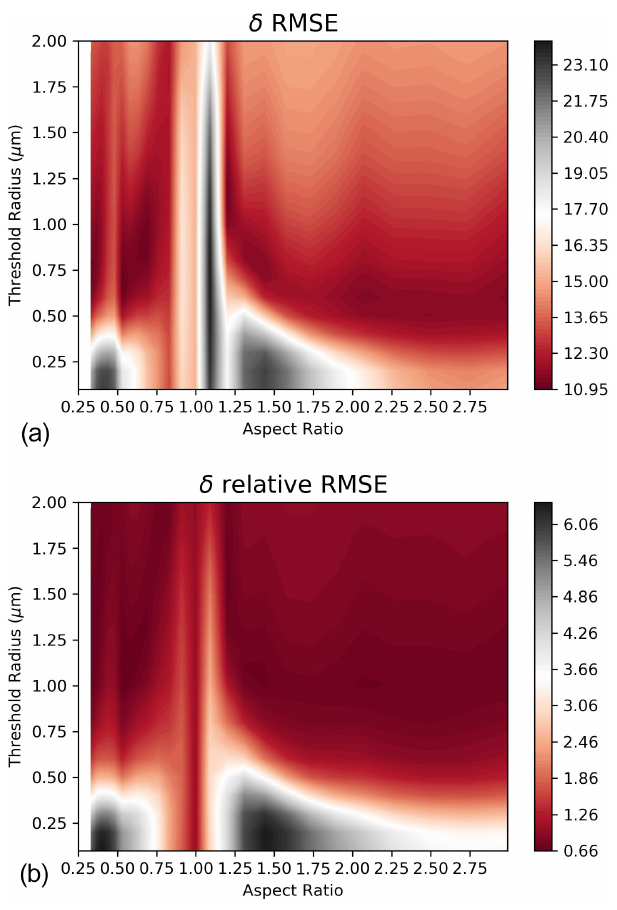
Figure 3. Contour plot of the RMSE (a) and relative RMSE (b) of the measured and modelled aerosol depolarization δ A .